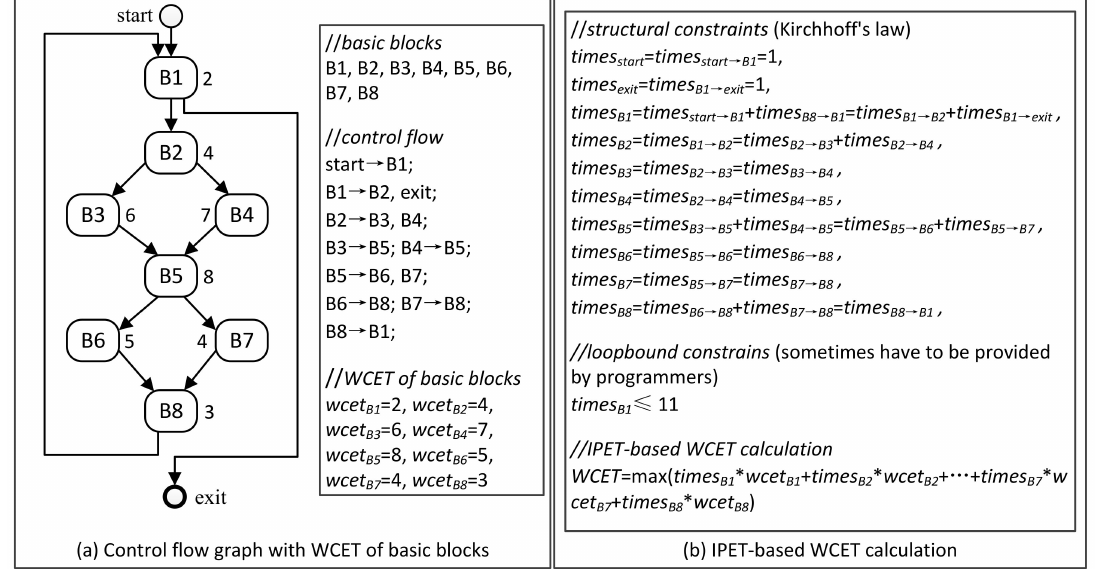
Figure 1. IPET-based WCET calculation